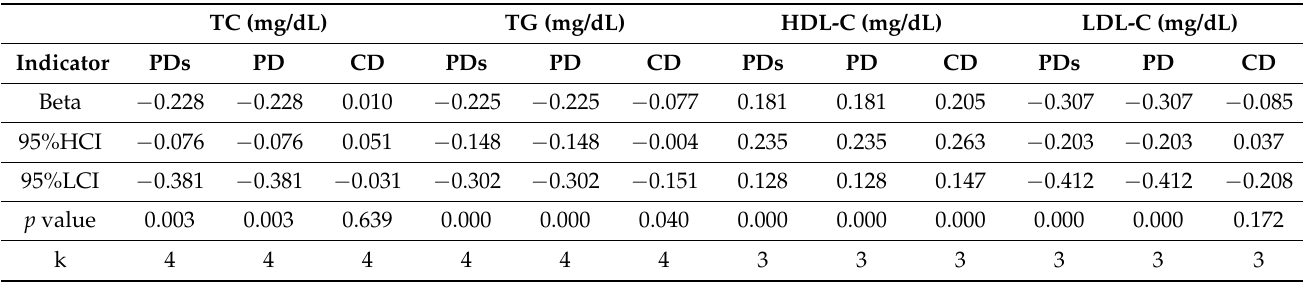
Table 5. Changes in lipid profile (total cholesterol, triglycerides, HDL-C, and LDL-C in long-term PDs, PD, and CD studies (over 6 months).